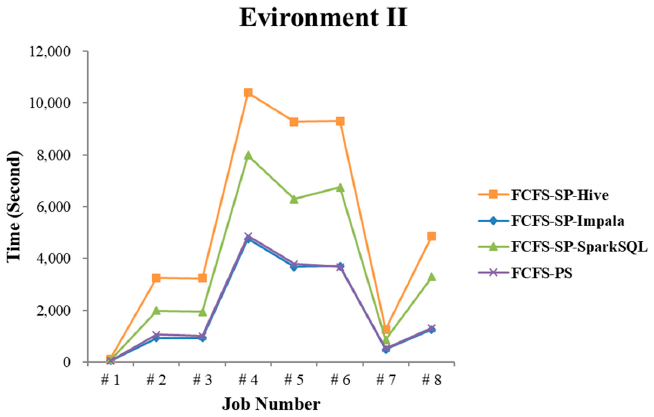
Figure 31. Execution time of each use case in test environment II. Appl. Sci. 2018 , 8 , x FOR PEER REVIEW 24 of 26